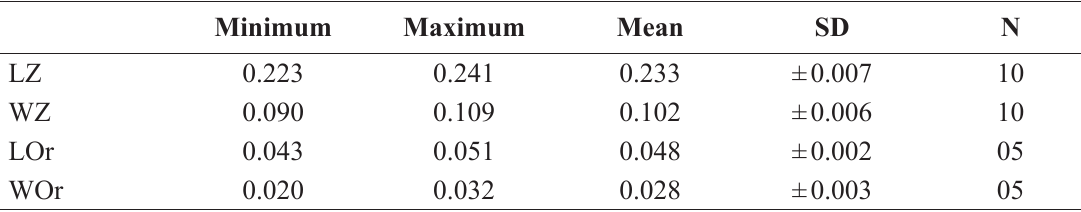
Table 7. Measurements in mm of Cellaria sp. (GIS/B 0515), Burdigalian, lower Miocene, Chhasra Formation, western Kachchh, Gujarat, India. Abbreviations: see Material and methods.